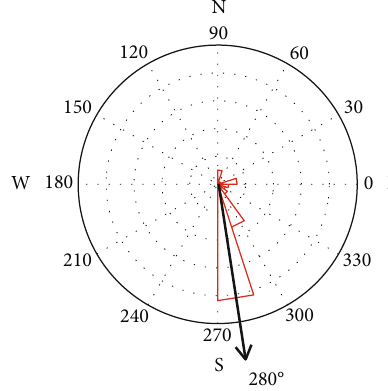
Figure 7: Estimated fracture orientation and fracture density near the well. Figure 8: Estimated rose diagram of the fracture